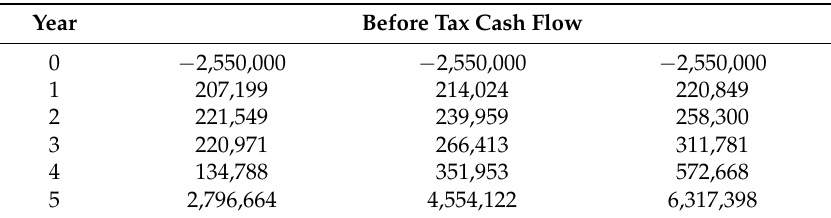
Table 14. Fuzzy amounts of Before Tax Cash Flow.